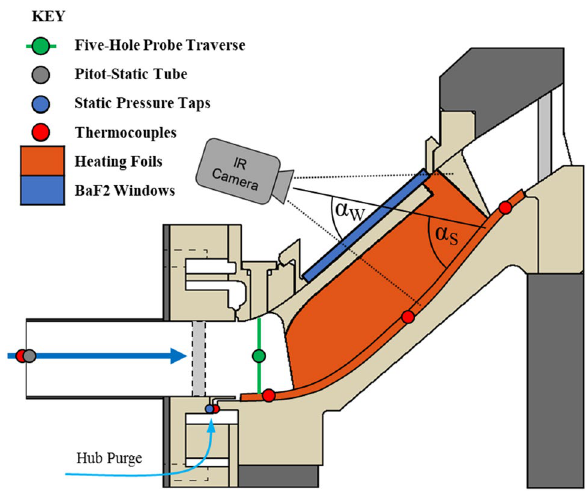
Fig. 2 Sector-cascade rig instrumentation (adapted from